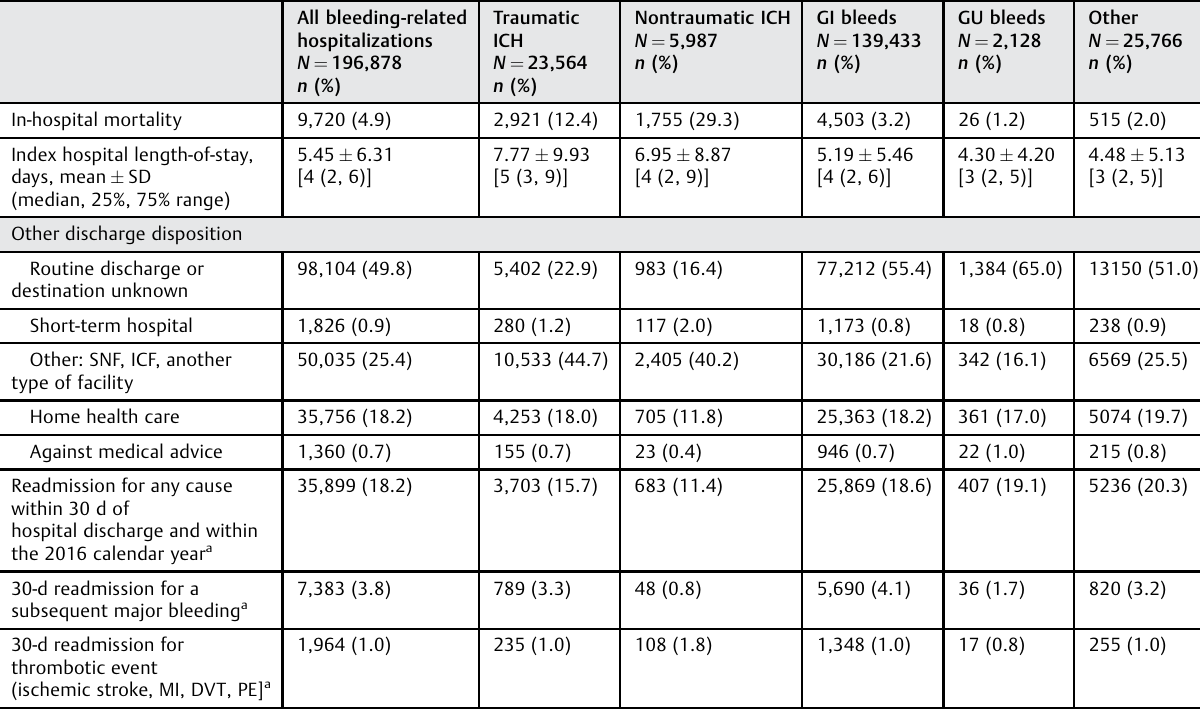
Table 2 Crude incidence of outcomes in patients experiencing a bleeding-related hospitalization All bleeding-related hospitalizations